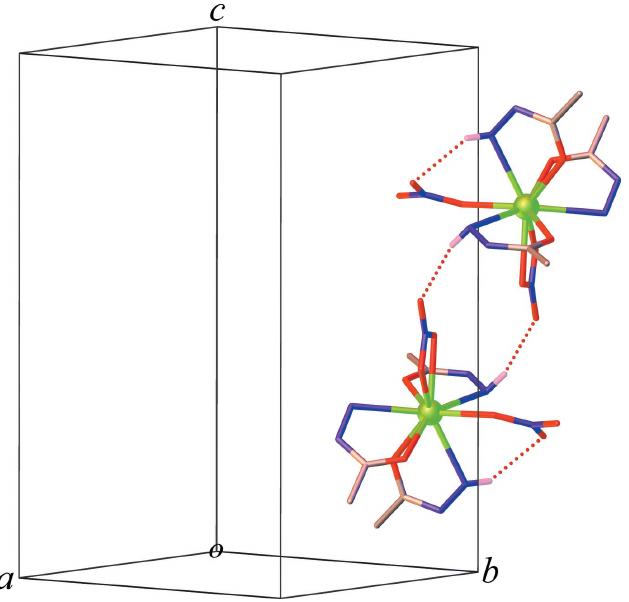
Figure 3 Dimer formation through N—H (cid:2)(cid:2)(cid:2) O hydrogen bonds (dashed lines) in 1 (hydrogen atoms, except those forming hydrogen bonds, are omitted for clarity).